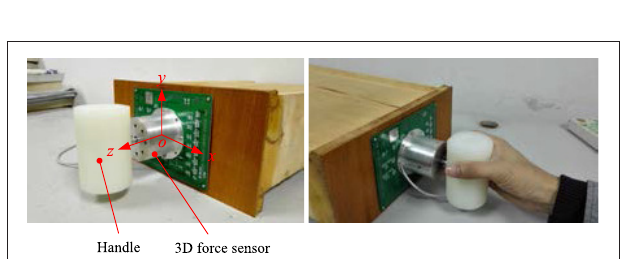
FIGURE 6 | The grip force sensor and its manipulation sketch.